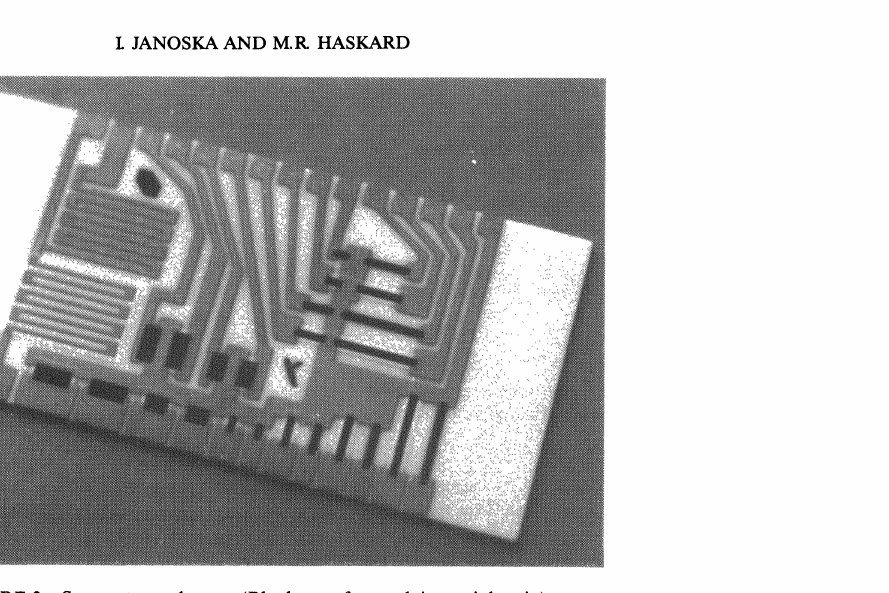
FIGURE 3 Sensor test substrate (Blocks are for applying axial